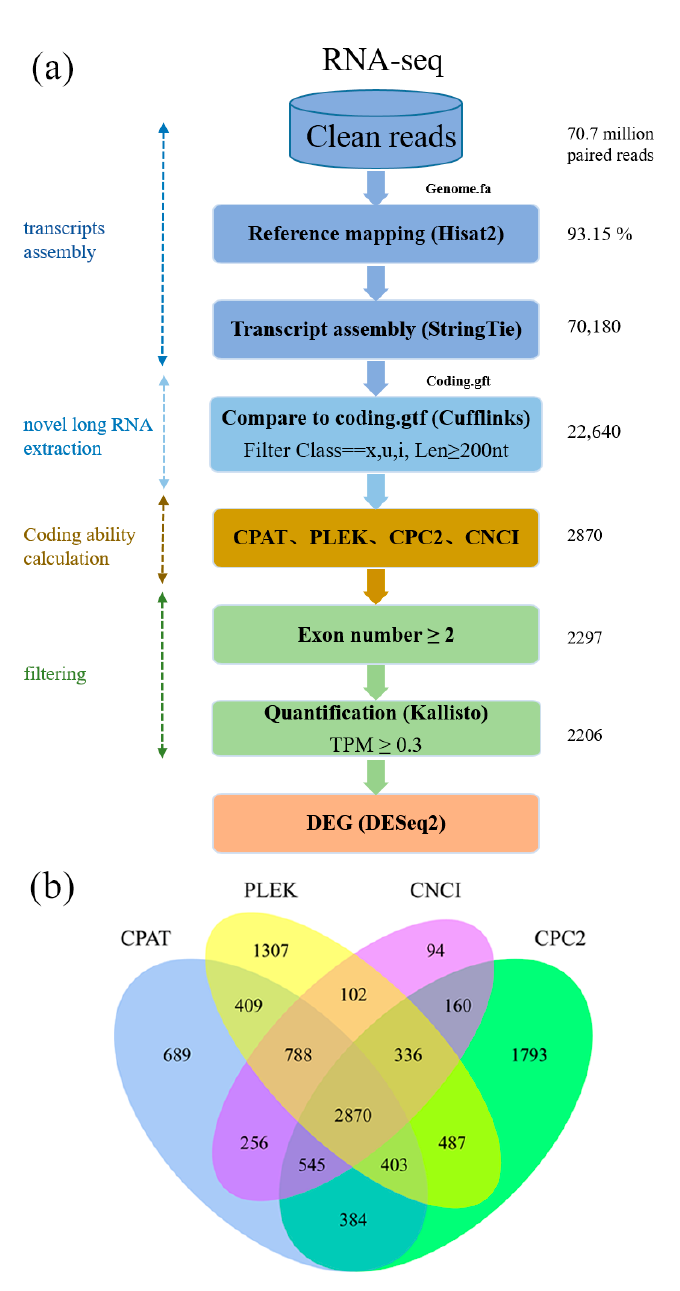
1 Figure 1. Complete computational pipeline for the systematic identification of long non-coding RNA (lncRNAs) in allotetraploid Cucumis hytivus leaves. ( a ) Detailed schematic diagram of the bioinformatic pipeline for the identification of leaf lncRNAs. ( b ) Venn diagram of the number of candidate lncRNAs filtered by CPC2, CNCI, CPAT, and PLEK. CPC2: coding potential calculator; CNCI: coding-noncoding index; CPAT: coding potential assessment tool; PLEK: a tool for predicting long non-coding RNAs and messenger RNAs based on an improved k-mer